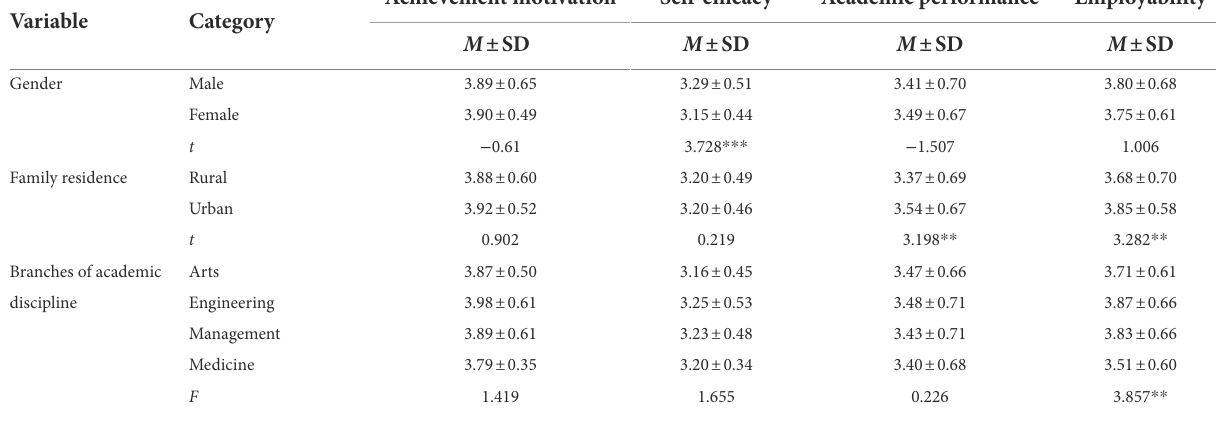
TABLE 3 Basic description of the variables ( N =